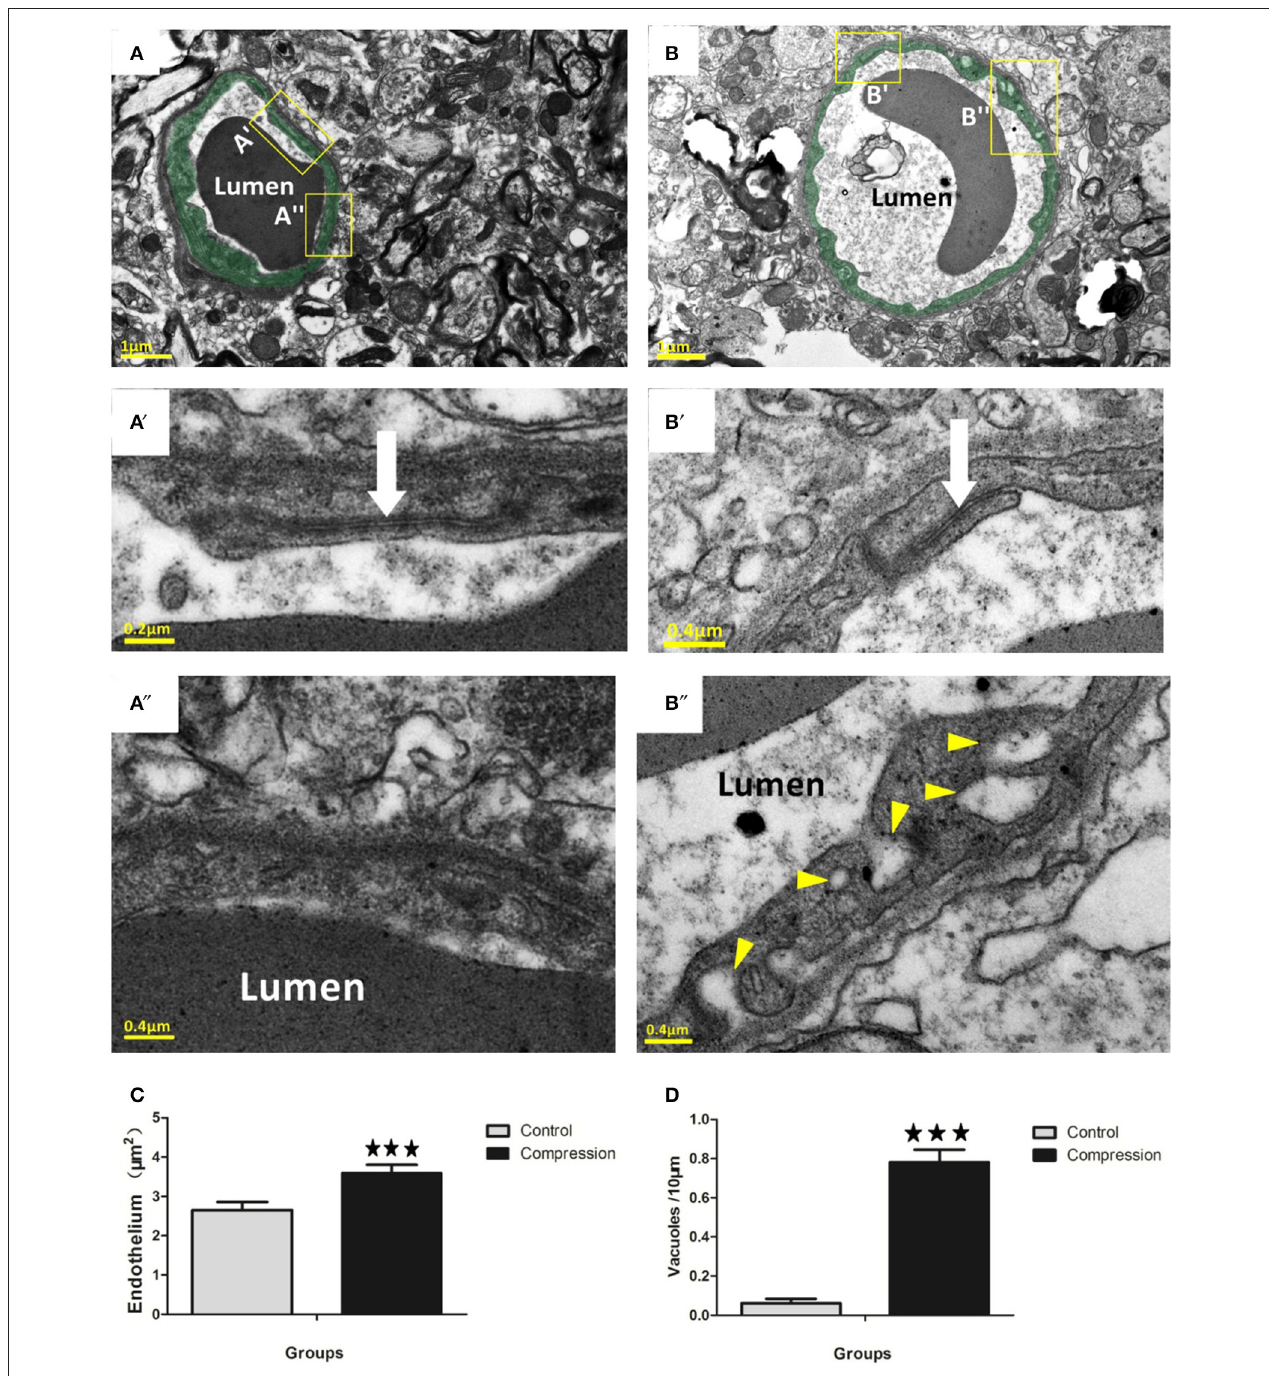
FIGURE 4 | Electron micrographs (EMs) of capillaries in the control group (A) . Endothelium is lightly shaded as green (A,B) . Insets (A ′ , A ′′ ) below the image shows a relatively thin endothelial layer (A ′′ ) and intact TJs (white arrow in A ′ ). EMs of capillaries in the compression group (B) . Insets (B ′ ,B ′′ ) show that the slightly swollen endothelium was densely packed with putative caveolae-like vesicles (arrowheads) on the luminal and abluminal sides. Several TJs in the compression group (white arrows in B ′ ) were still intact. Histograms show that endothelial thickness (C) and vacuole formation (D) were significantly increased in the compression group. Vacuoles are expressed as vacuoles per 10mm of the vascular endothelium circumference. The number of capillaries analyzed per group was 30, sampled from 12 rats per group. *** P < 0.001 relative to controls.